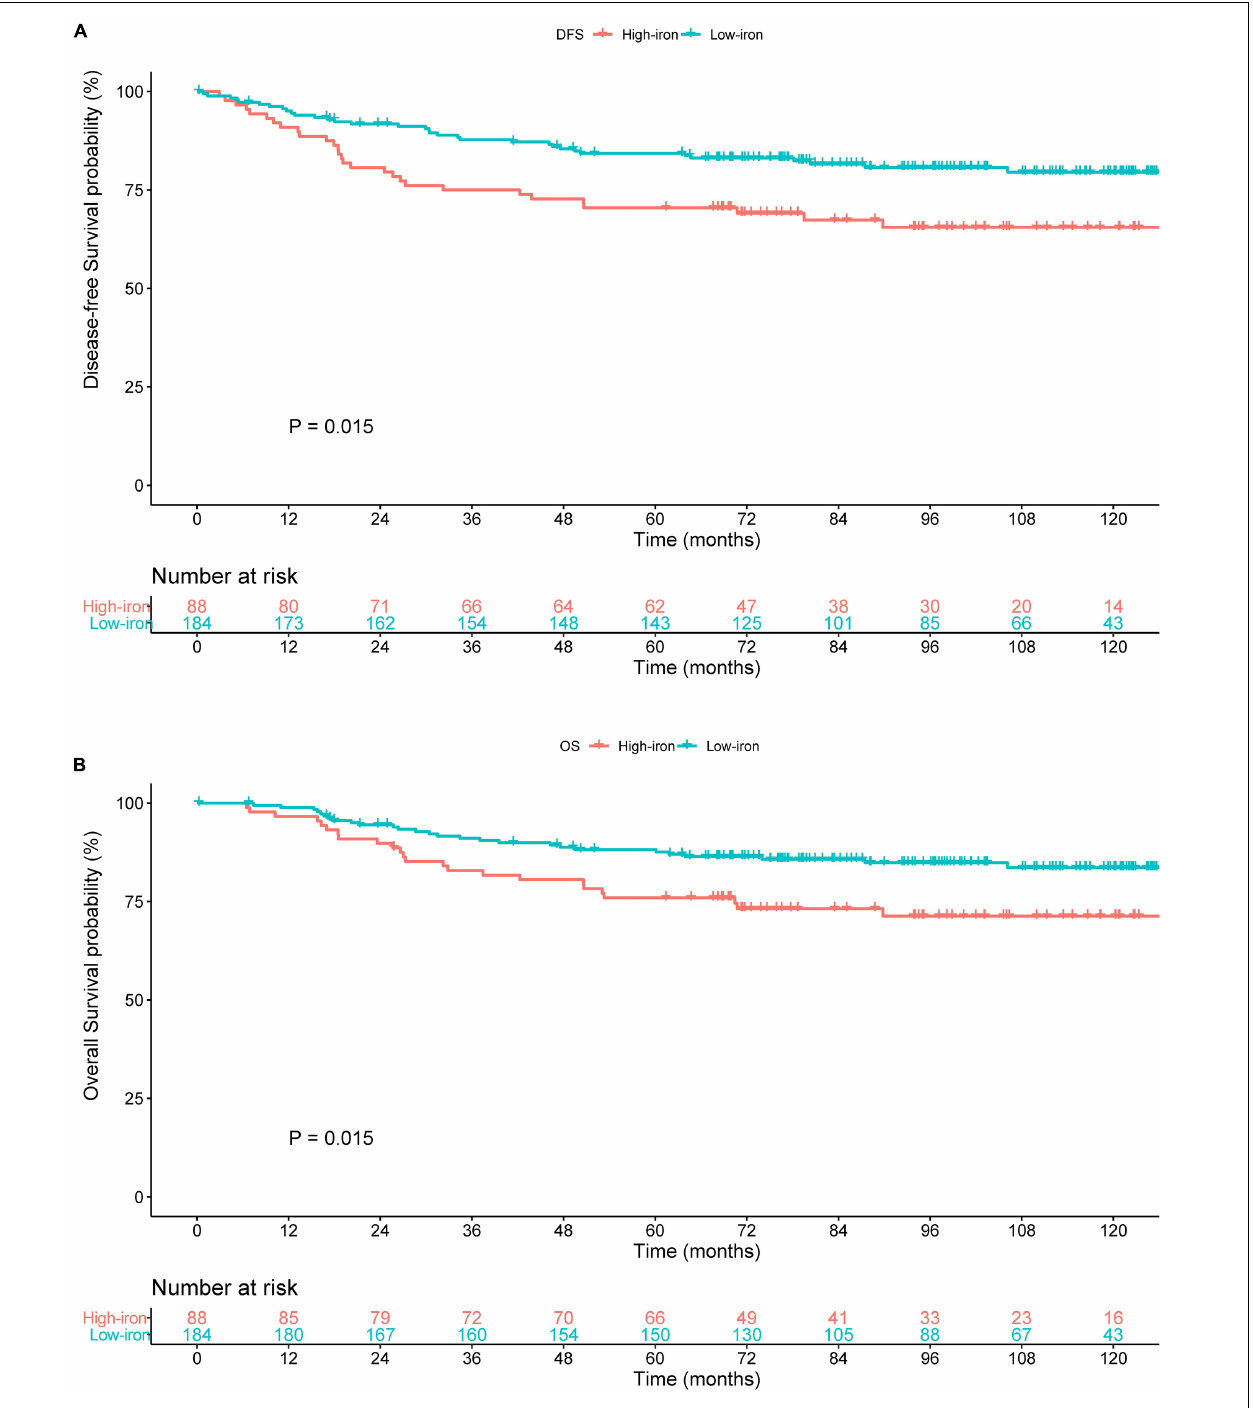
Frontiers in Cell and Developmental Biology |